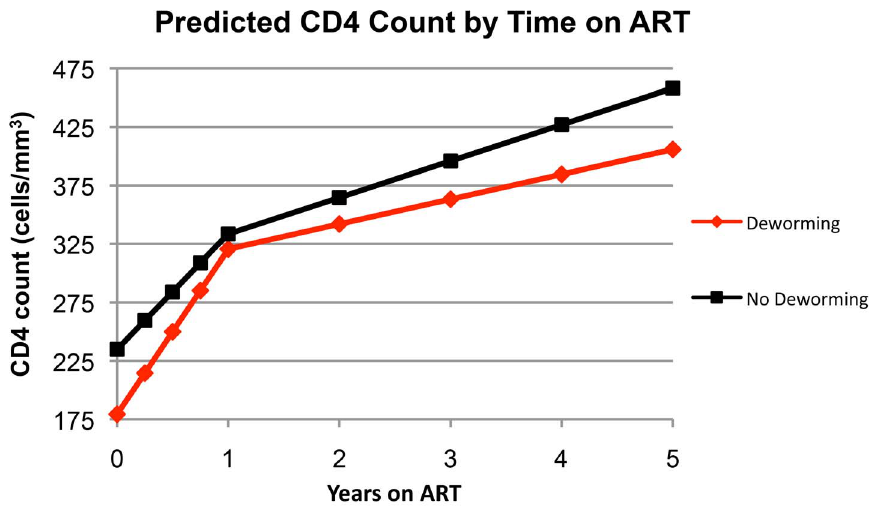
Figure 1. Predicted CD4 count by time on ART. Predicted values are based on the multivariable linear regression model y= a + b 1 t + b 2 t + b 3 t + b 4 t , where the independent variable, y , is CD4 count; the dependent variable, t , is time on ART, the y -intercept, a , is CD4 count at t =0, and b 1 – b 4 are respective b -coefficients for the co-variables age, TB co-infection, deworming, and deworming*time interaction.